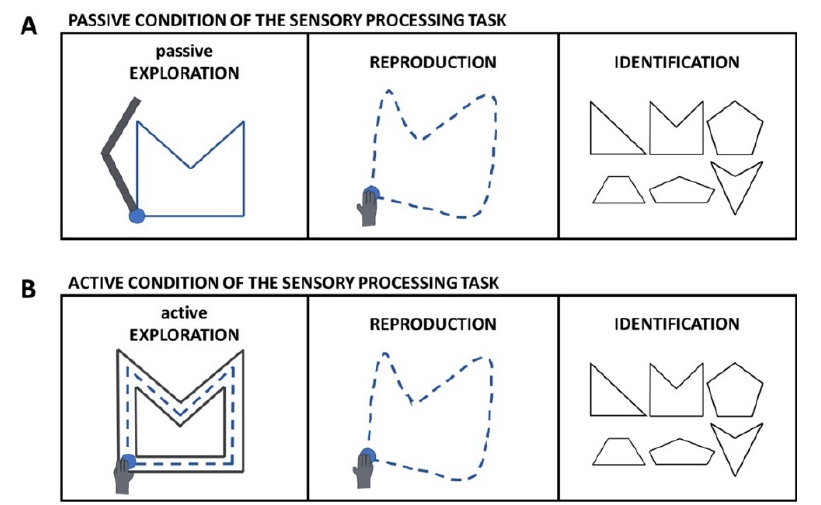
Figure 2. ( A ). Passive condition of the sensory processing task. Left panel: Passive exploration of the shape with the affected or non-dominant arm. Middle panel: Reproduction of the shape with the less affected or dominant arm. Right panel: Identification of the explored shape. ( B ). Active condition of the sensory processing task. Left panel: Active exploration of the shape with the affected or non-dominant arm. Middle panel: Reproduction of the shape with the less affected or dominant arm. Right panel: Identification of the explored shape. Left and middle panels: Blue dashed line = active movement; Solid blue line = passive movement; Solid black line = virtual walls delimiting the shape.